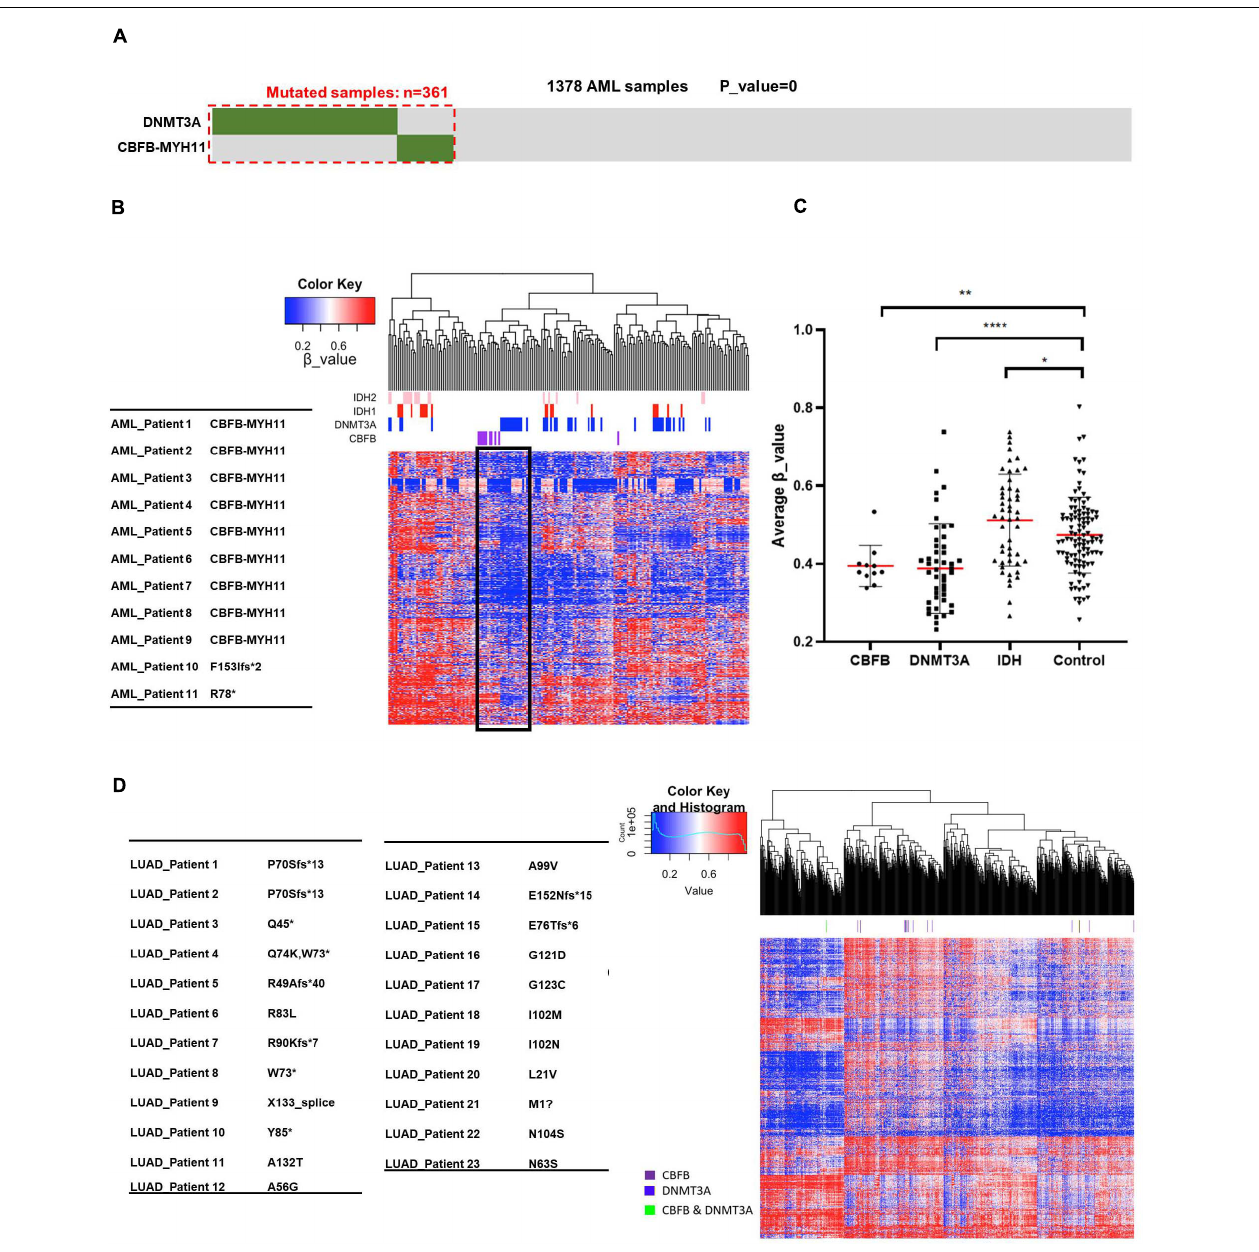
FIGURE 2 | AML samples bearing CBFB-MYH11 mutations have a similar DNA hypomethylation signature as DNMT3A mutant tumors. (A) Mutually exclusive mutation pattern of DNMT3A and CBFB-MYH11 seen in the expanded tumor samples. Somatic variants in DNMT3A and CBFB-MYH11 were identified from a total of 1,378 AML cases, in which 361 cases carried at least one mutation. (B) Heatmap and hierarchical clustering of AML patients based on DNA methylation. Level3 DNA methylation data of AML samples was download from TCGA database. Unsupervised hierarchical clustering was performed with hclust function with R (heatmap.3 package) using the most variably methylated CpG sites ( n = 8,030, SD > 0.27). β _value was used to indicate the methylation level of each CpG site. (C) Methylation level of AML patients with different genomic alterations. Each point is one patient. Average β _value was calculated with data from (B) .